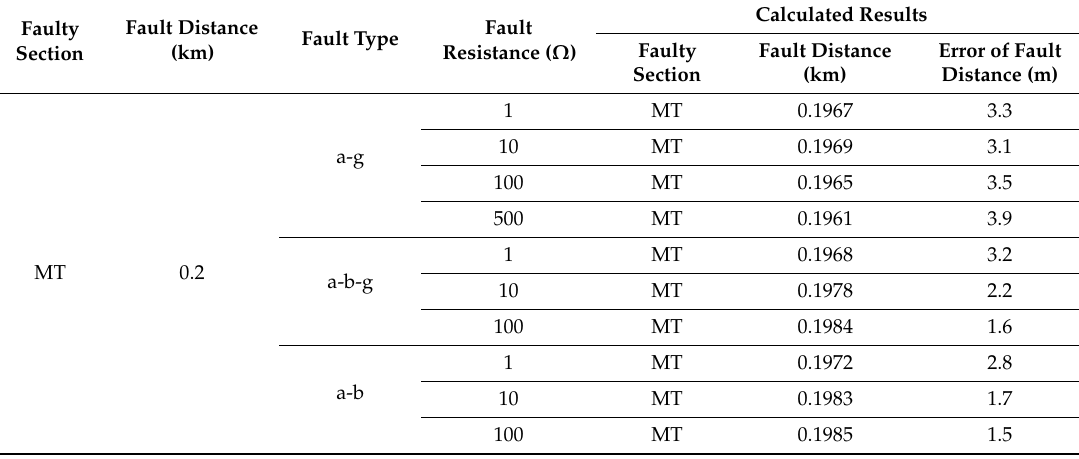
Figure 7. Error of computed fault distance for a-b fault on the PT section. Table 2. Partial calculated results of the fault location in a three-terminal line.